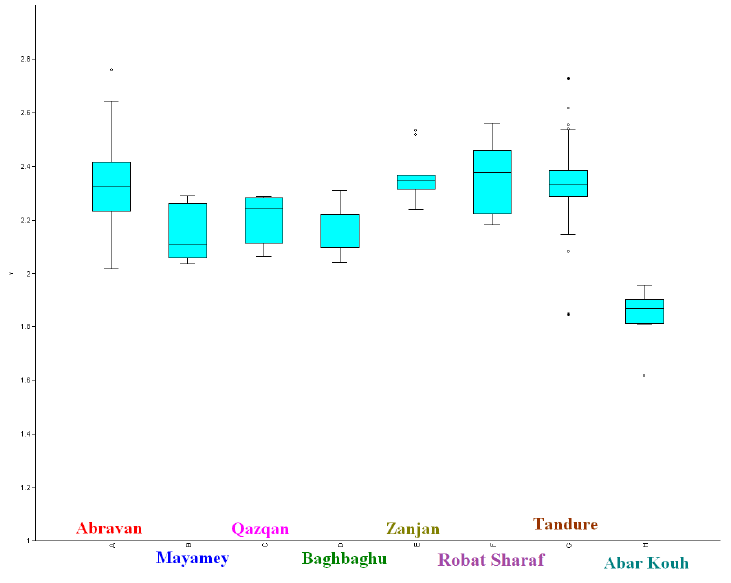
FIGURE 17 : Mean and box plot variation of the length of M/1 in Meriones in different